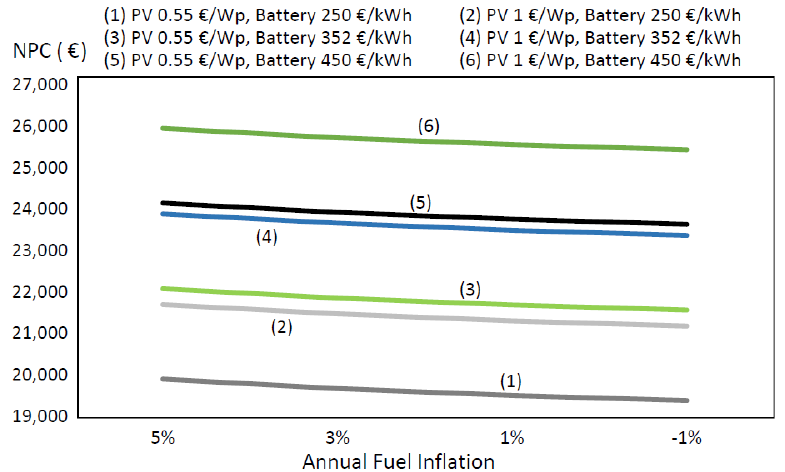
Figure 9. Sensitivity analysis, PV + Diesel + Battery systems. NPC of the optimal solutions.